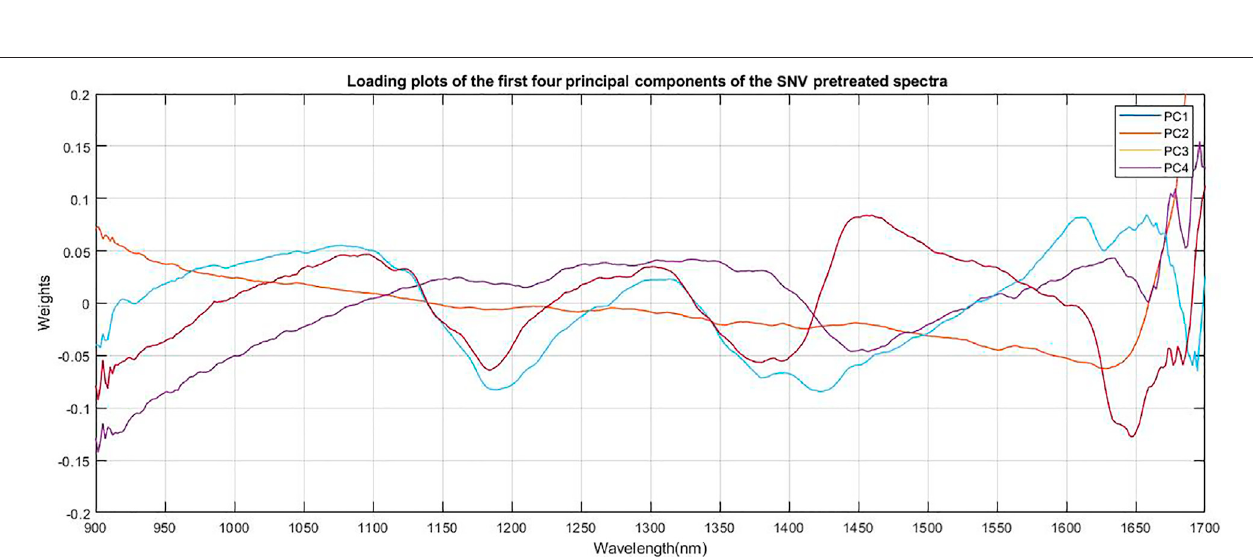
FIGURE 4 | Loading plots of the fi rst four principal components of the SNV pretreated spectra of dried Andrographis paniculata plant material.